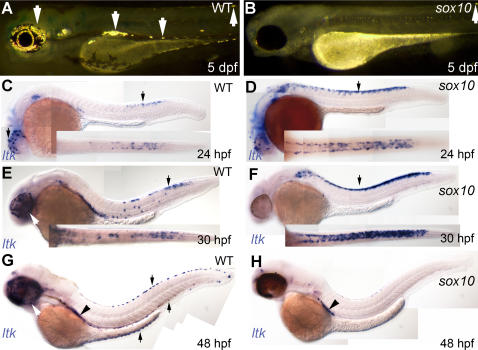
Iridophore phenotype and ltk expression patterns in sox10 mutants.A, B) Iridophores (arrows) are prominent in 5 dpf WT (A), but almost absent in sox10m618 (1 residual cell is seen here in the dorsal stripe)(B) and sox10t3 (not shown) mutants. C–H) ltk expression (purple, arrows) patterns in WT (C, E, G) and sox10t3 mutants (D, F, H); stages as shown. Arrows indicate ltk-expressing cells on eye and in premigratory NC (24 and 30 hpf) and in iridoblasts (48 hpf); insets show dorsal view of posterior trunk and tail. Arrowhead labels ltk-expressing cells of lateral patch.